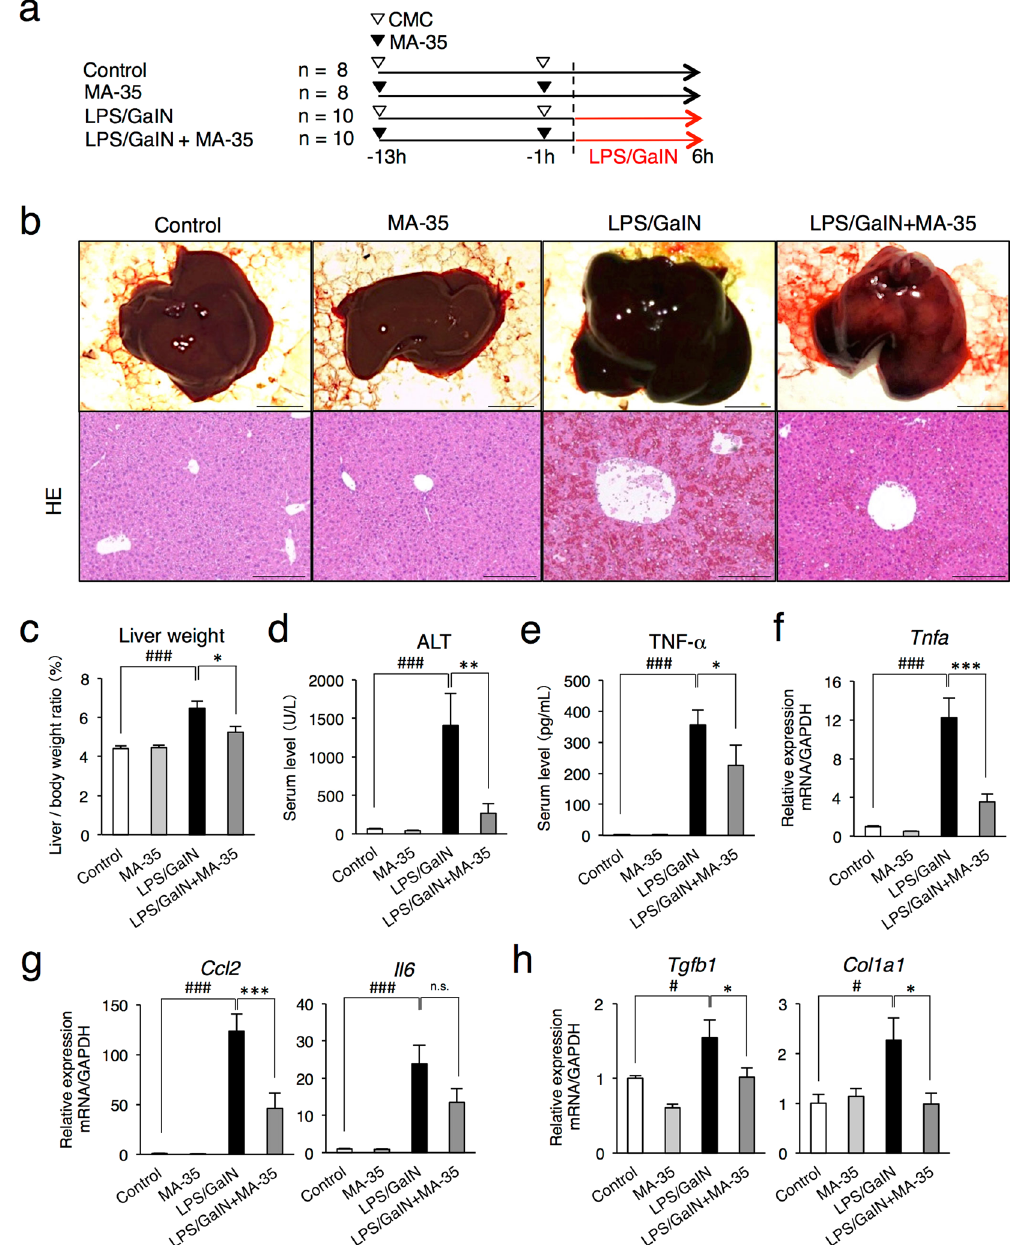
Figure 3. Effect of MA-35 on LPS/GaIN-induced liver injury in mice. ( a ) Experimental design. MA-35 or CMC was orally administrated 13 h and 1 h prior to LPS/D-GaIN injection. All mice were sacrificed at 6 h after the injection. ( b ) Representative gross appearance and HE staining of liver at 6 h after LPS/GaIN injection. Scale bars are 1 cm and 50 μ m, respectively. ( c ) Changes in the liver/body weight ratio after LPS/GaIN injection. ( d ) Serum ALT activities were measured at 6 h and ( e ) Serum TNF- α as measured at 1 h after the LPS/GaIN injection. The hepatic mRNA levels of ( f ) Tnfa , ( g ) Ccl2 , Il6 and ( h ) Tgfb 1 , Col1a1 were measured by real-time PCR. # p < 0.05, ### p < 0.001 v.s. Control, * p < 0.05, ** p < 0.01, *** p < 0.001 v.s.